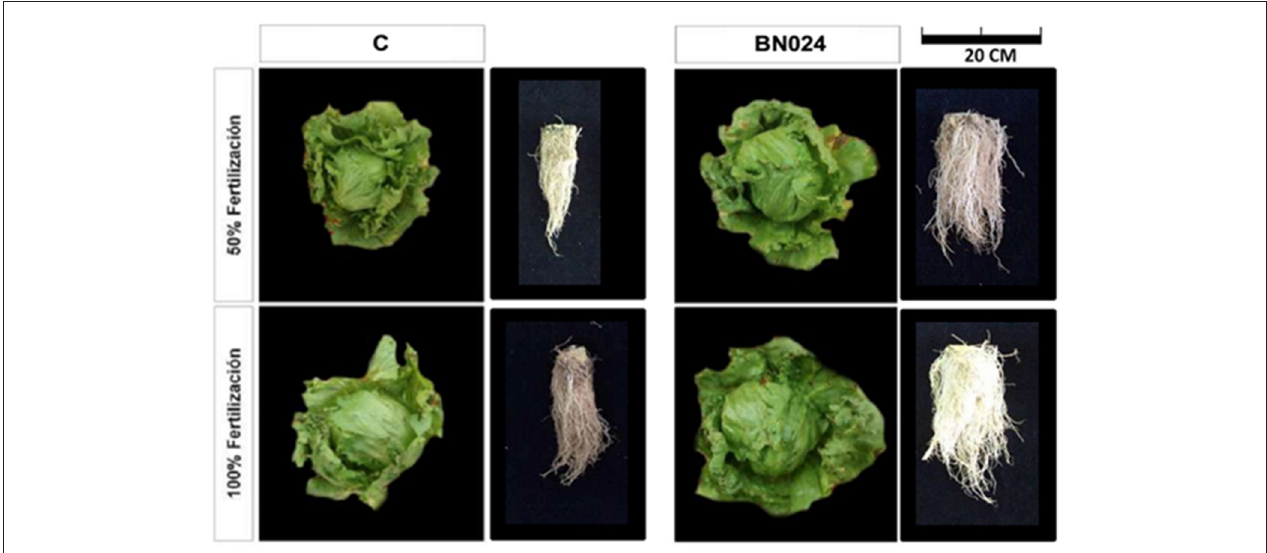
FIGURE 7 | Photographs from the lettuce field trail; left: Control (C) aerial and root lettuce development at harvest with 50 and 100% fertilization; right: BN0024 (BN024) aerial and root lettuce development at harvest with 50 and 100% fertilization.